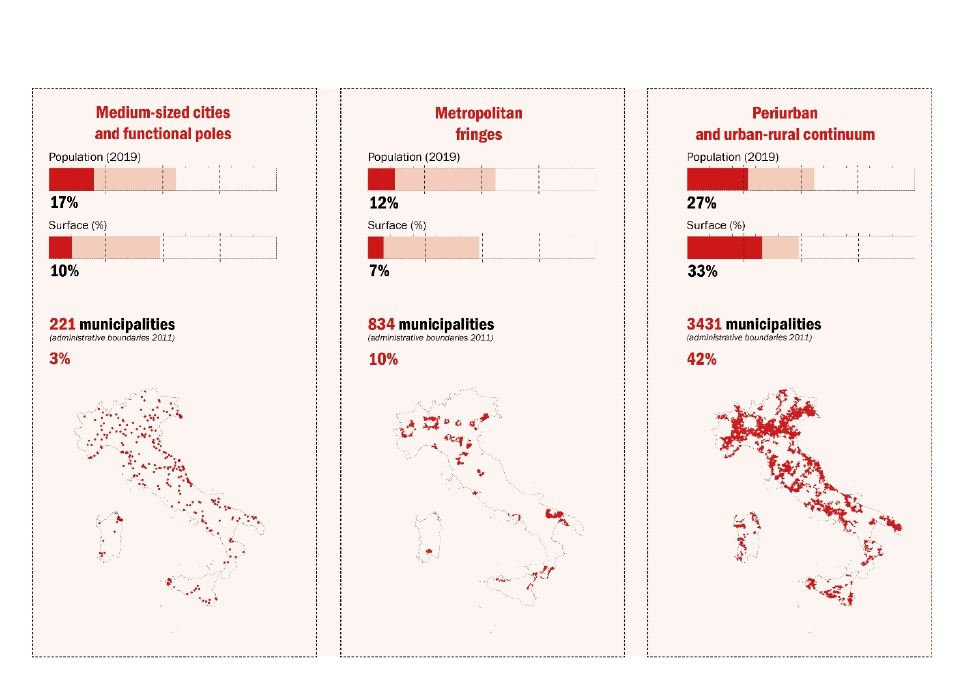
Figure 2: An articulated reality in which we can distinguish at least three settlement